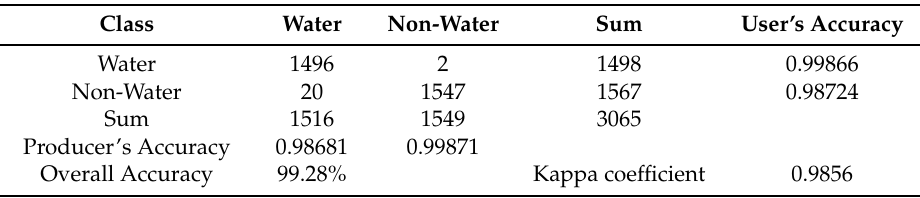
Table 8. Validation statistics of ML for water body identification.